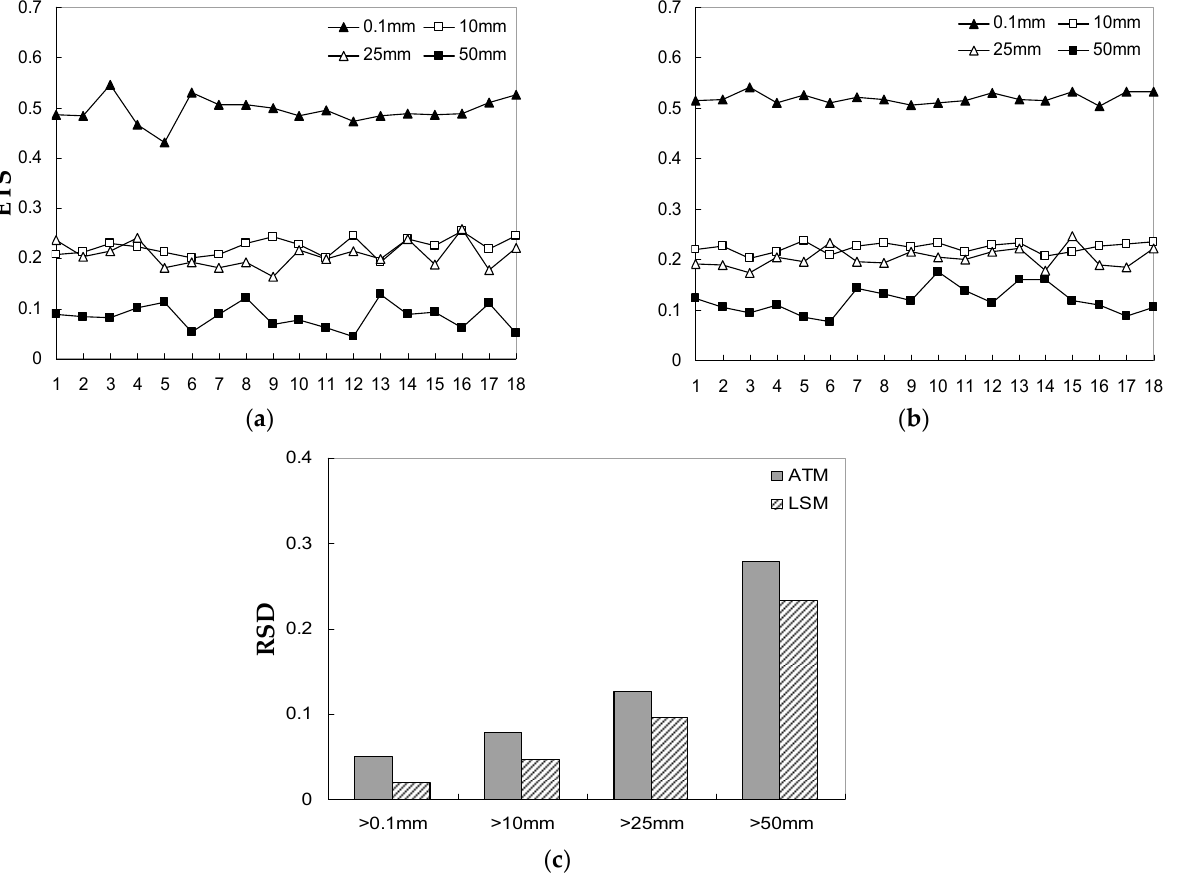
Figure 7. Ensemble forecast ETS and its relative standard deviation (RSD) for various precipitation intensity levels in the ATM and LSM subsets (Test No. 18 represents the average of the subset). ( a ) ATM subset ETS, ( b ) LSM subset ETS, ( c ) RSD at various precipitation intensity levels.